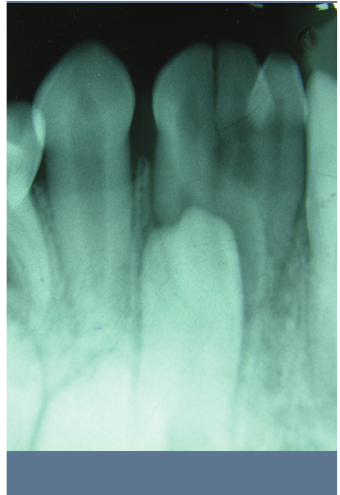
Figure 3: Intraoral periapical radiograph showing fusion of two primary incisors with supernumerary tooth, with separate pulp chamber and root canals, erupting succedaneous lateral incisor, canine, and absence of central incisor on right